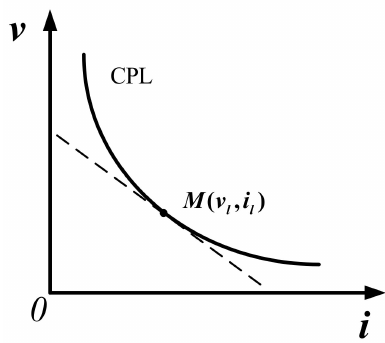
Figure 2. Representative structure of CPLs.